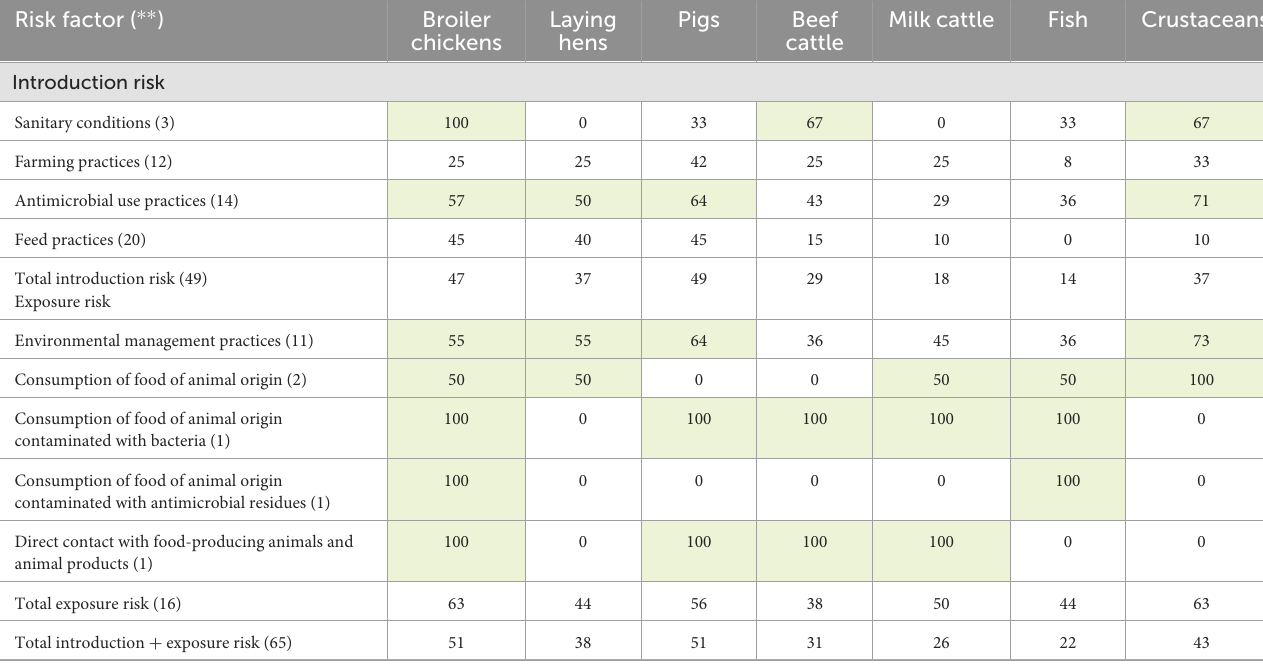
TABLE 9 Percentage of subfactors that present risks ∗ based on the qualitative risk assessment for human health, by risk factor and animal production